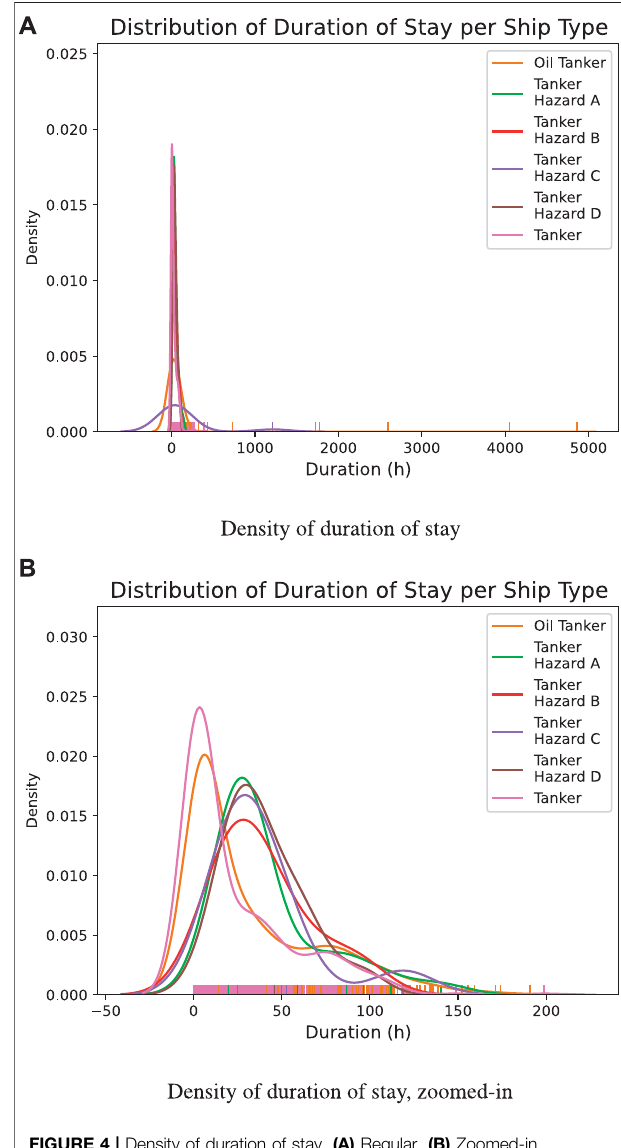
FIGURE 4 | Density of duration of stay. (A) Regular, (B)